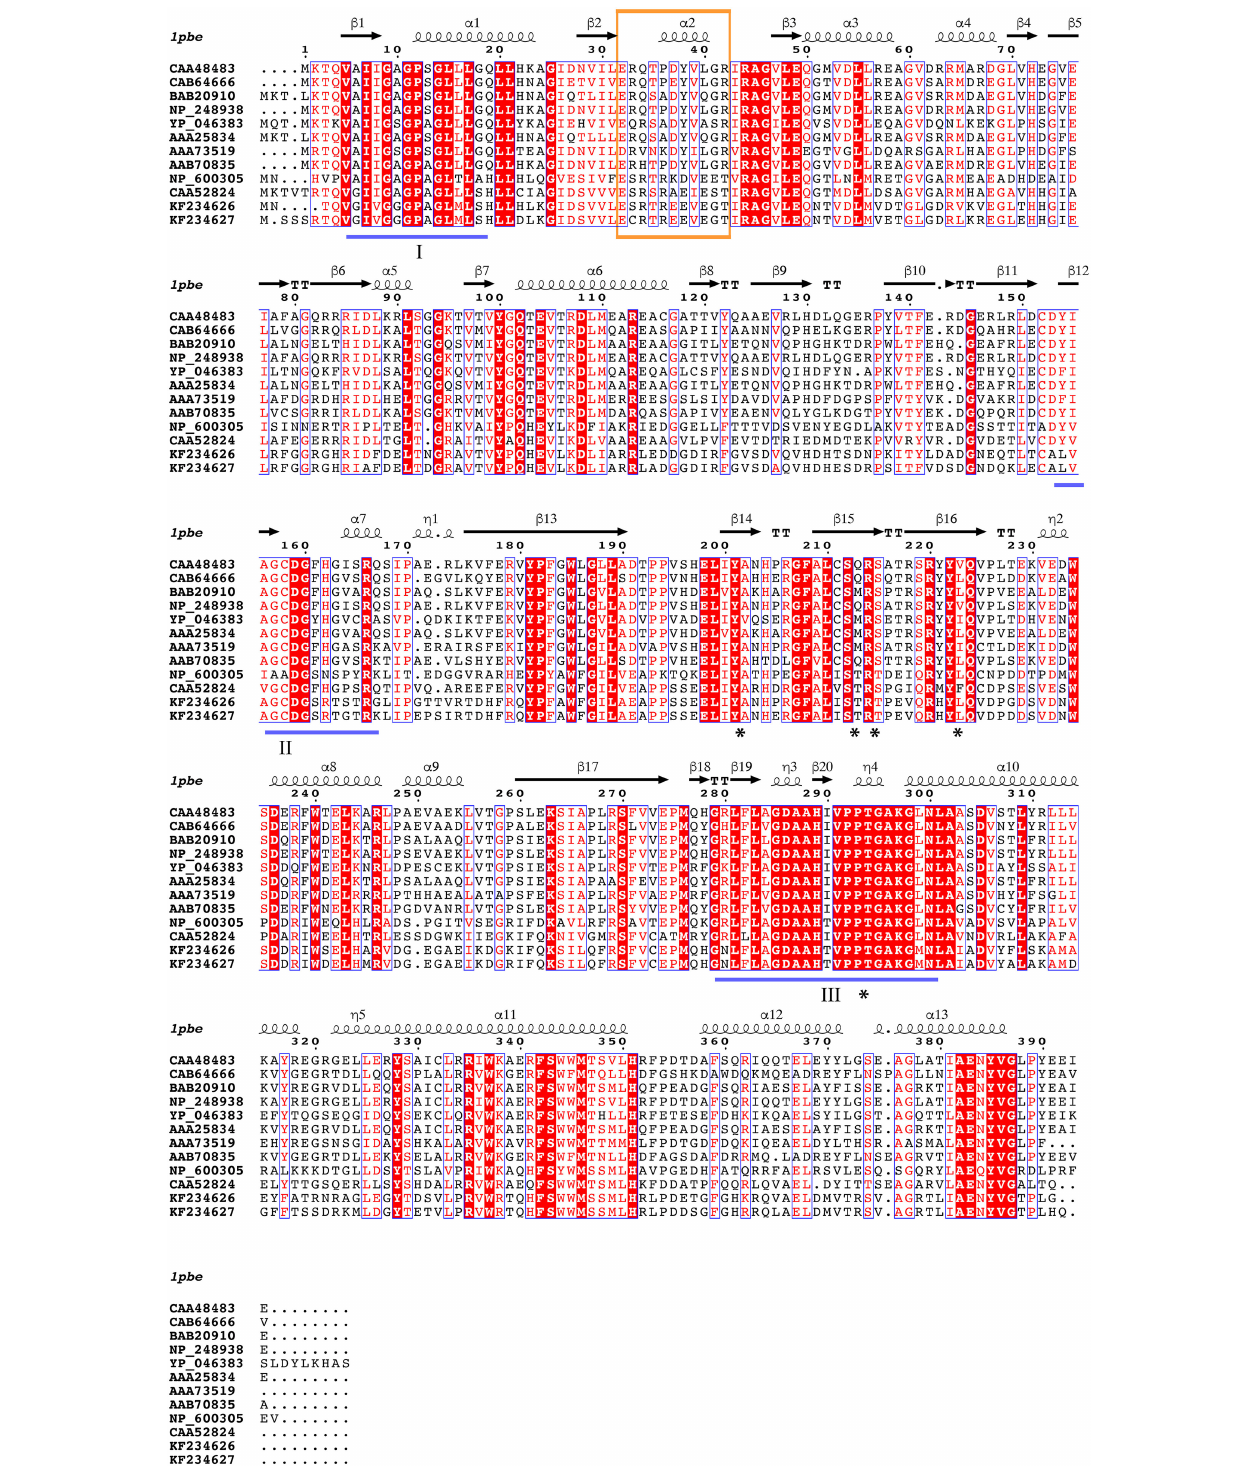
FIGURE 2 | Multiple sequence alignment of selected PHBHs. Accession numbers are given in Table 1 . PHBH Ro is KF234626 and PHBH Rr is KF234627. Identical residues are shown in red. Flavin binding motifs are underlined in blue (I: “GXGXXG”; II: “DG”; III: “GD”; Eppink et al., 1997). Secondary structure assigned from the PHBH Pf crystal structure (PDB ID: 1pbe) is indicated above the sequences. The pyridine dinucleotide cofactor recognizing fingerprint region is boxed and residues in direct contact with the substrate are marked with an asterisk. The diagram was produced using ESPript (Robert and Gouet, 2014).